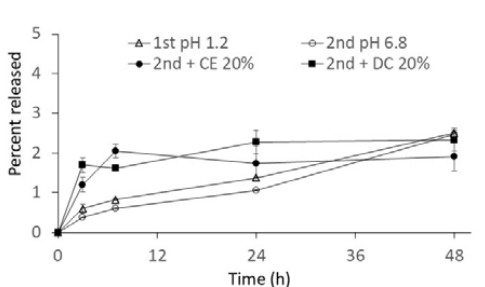
Figure 3 . Release profiles from NG(S) with a high drug content (21%) in media of JP 17 first fluid (1st pH 1.2) and JP 17 s fluid (2nd pH 6.8) without or with a 20% cecal content homogenate (2nd +